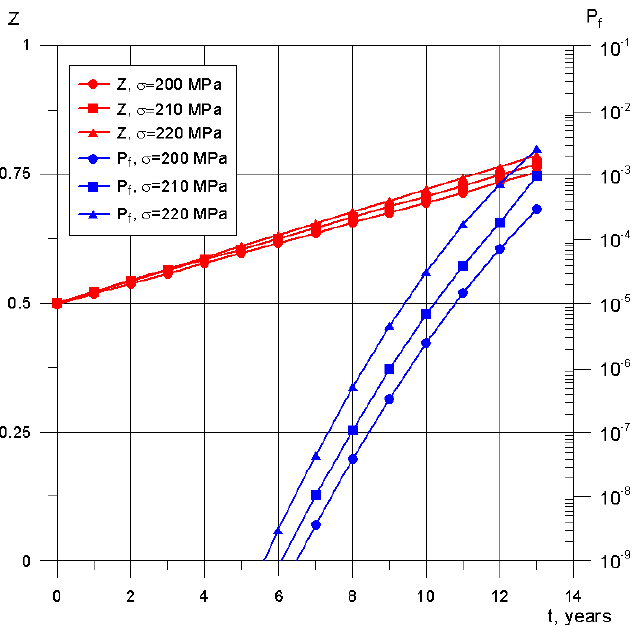
Figure 8. Material fatigue-creep wear and probability of turbine rotor failure over 13 years of operation, Z 0 = 0.5. Energies 2022 , 15 , 5019